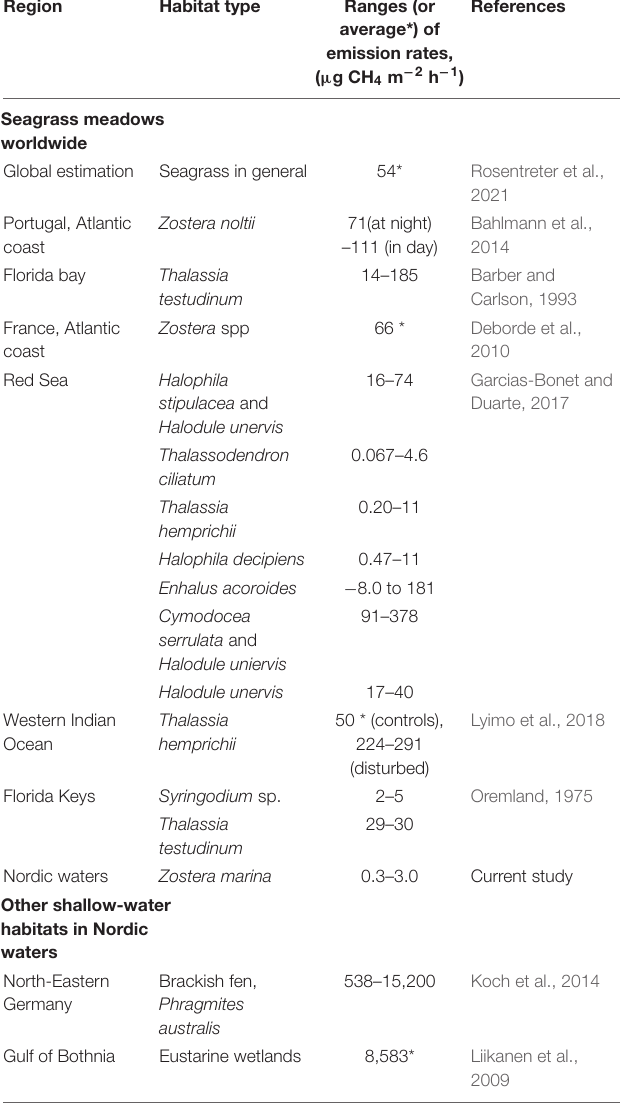
TABLE 3 | Sediment methane (CH 4 ) emission rates from seagrass meadows worldwide and other shallow-water habitats in Nordic waters, using sediment-to-air filled pocket chamber techniques, reported in the literature and in the current study.